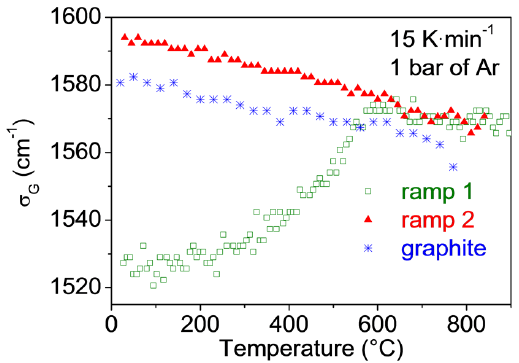
Figure 22. Raman spectra of amorphous carbon (a ‐ C:H with about 30 at.% H) obtained with different laser wavelengths.